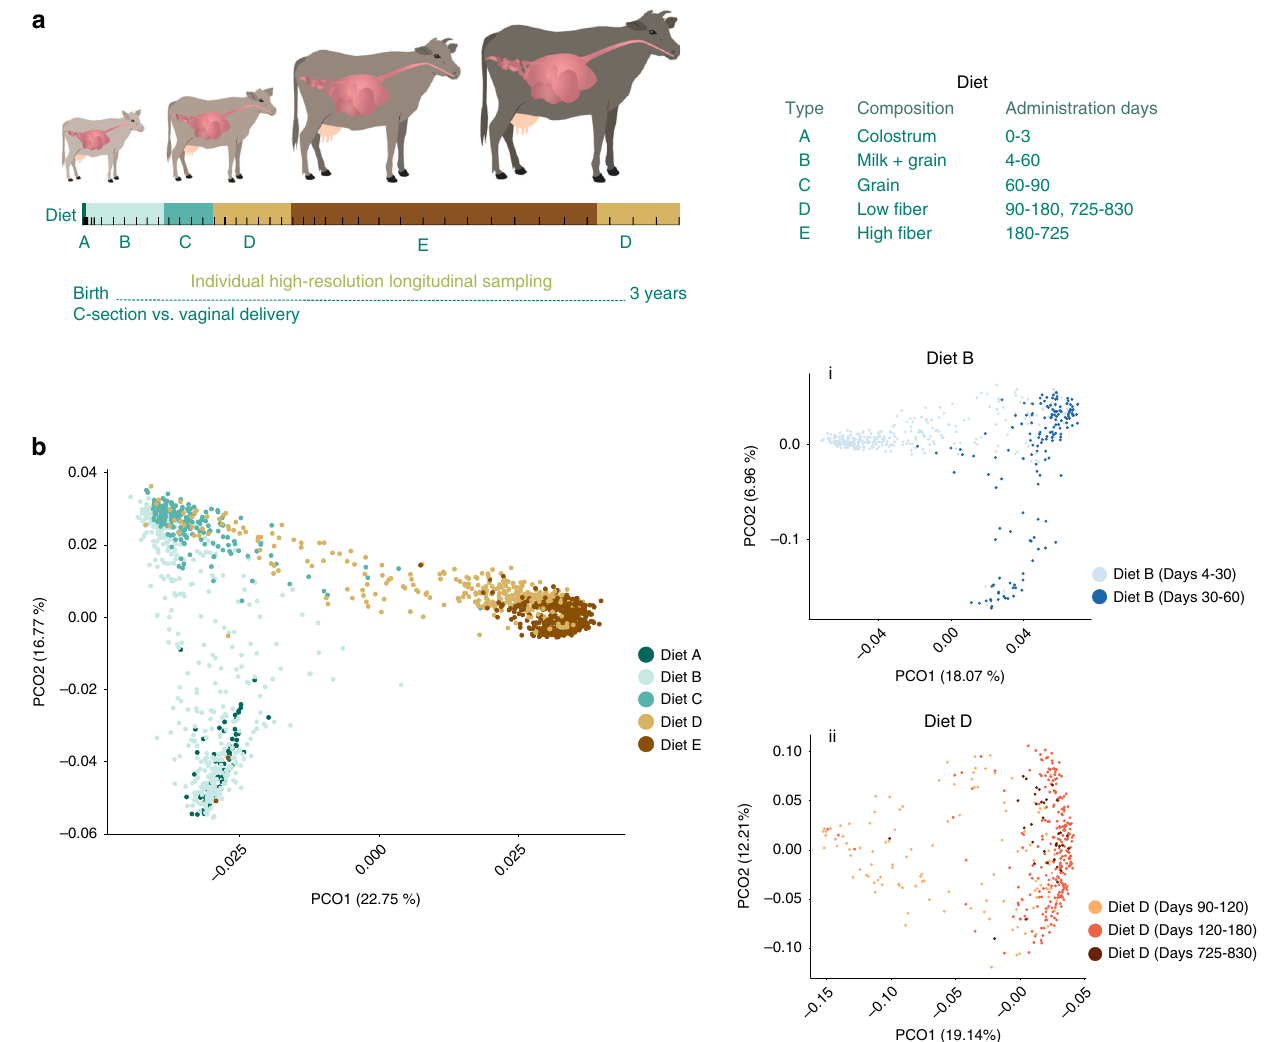
Fig. 1 Age plays an important role in community assembly dynamics. a The experimental setup consisted of 45 cows (27 delivered vaginally and 18 via C- section), sampled to a minimum of 180 days and over a period of up to 830 days for a third of the cohort (3 years), resulting in high-resolution sampling of more than 1600 samples (bars represents sampling points). The animals were fed with standard dairy-feeding protocols (table on the right), kept under the same conditions, and housed together from the third month of life. See Supplementary Fig. 2 for further details on the sampling regime. b Principal coordinate analysis (PCoA) based on Bray – Curtis metrics showed clustering of operational taxonomic units (OTUs) according to age and diet (PERMANOVA, P = 0.001, two-sided test). During microbiome development, age-dependent clustering was identi fi ed within the same dietary period, where animals were fed with (i) Diet B and (ii) Diet D (PCoA based on Bray – Curtis metrics, PERMANOVA, P < 0.05). Source data is provided as a Source Data fi